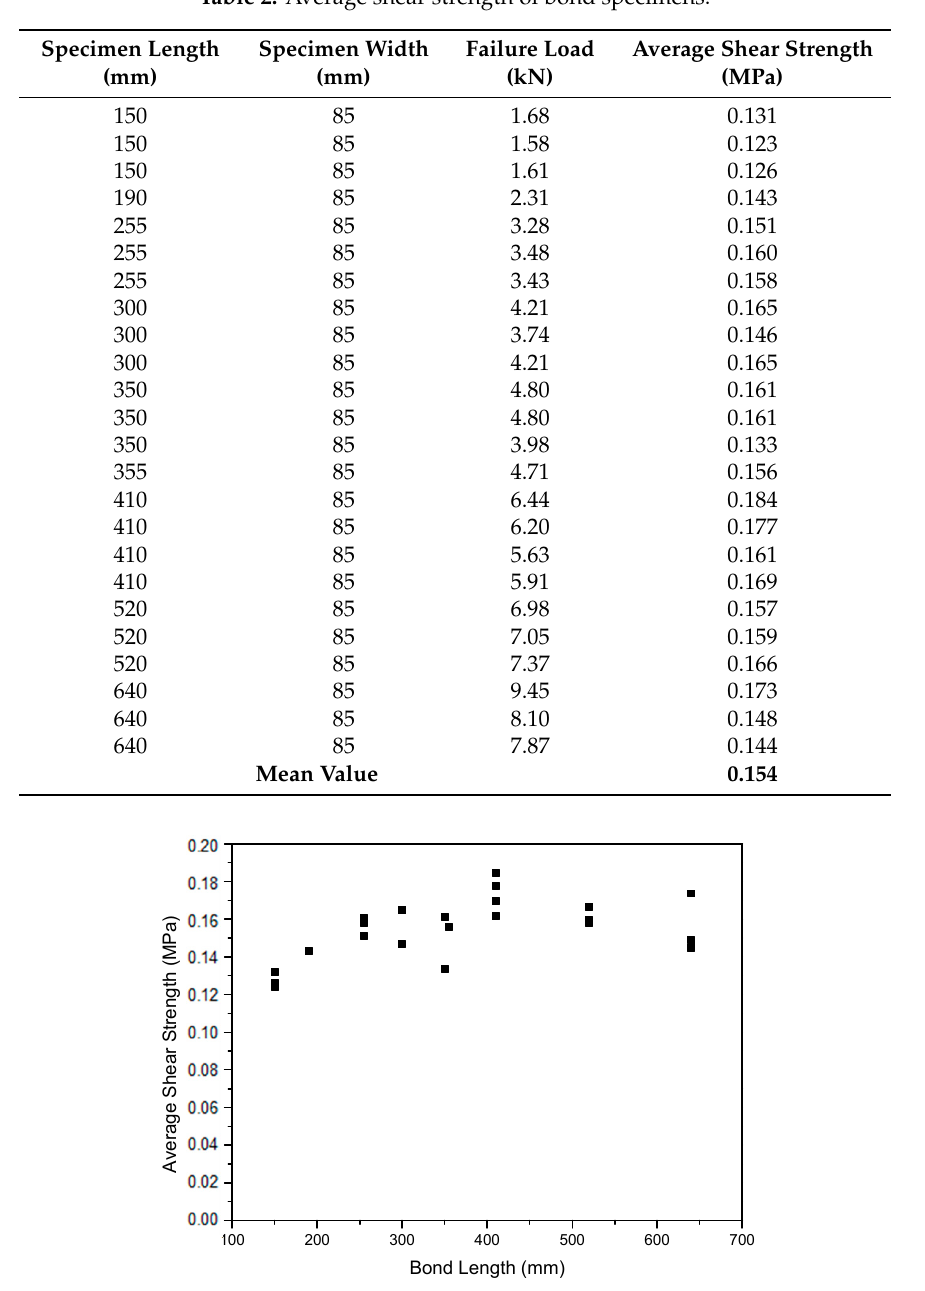
Table 2. Average shear strength of bond specimens.